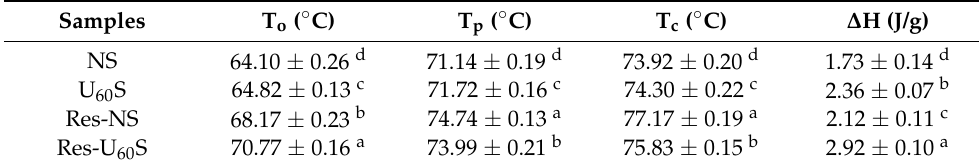
Table 1. Thermal parameters from DSC thermograms of different